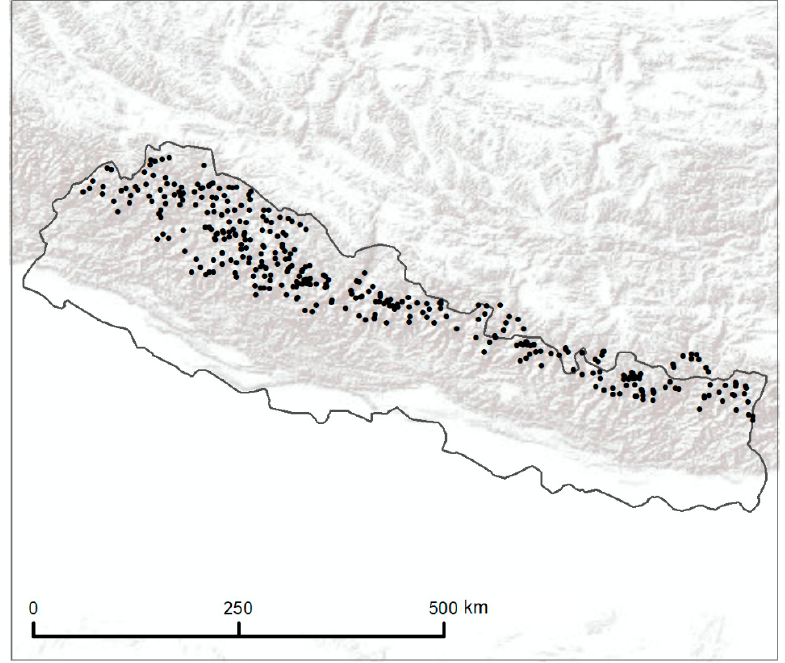
Figure 1. Occurrences of Betula utilis growing in the treeline ecotone in Nepal (N = 360). To limit the space for pseudo-absence selection (i.e., the space where the species is known not to occur, e.g., the Tibetan Plateau and the Indian lowlands), a convex hull with a buffer of 5° was drawn around the occurrences utilizing the R-package ‘rgeos’ [50]. Additionally, a buffer of 5 km was placed around the known occurrences to ensure that pseudo-absences where not placed directly next to occurrences. Following the procedure described in [25], a total of 4000 pseudo-absences were generated as randomly stratified points (i.e., one pseudo-absence per grid cell), as implemented in the R-package ‘sp’ [51]. The data were split into 80% training and 20% testing data utilizing the ‘caret’ pack- age [52]. We applied generalized linear models (GLM, [53]) and followed the procedure described in Bobrowski et al. [36], with binomial distribution, logit-link function, and polynomial terms of second order were used to build the model. We calculated the root mean square error (RMSE) in order to account for overfitting of the data (i.e., RMSE should be very similar between training and testing datasets), indicating a good fit of all